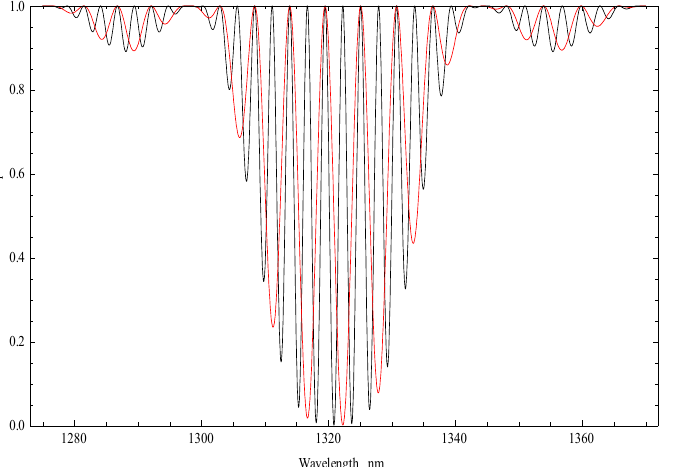
Figure 5. Spectrum for an LPG-based Michelson interferometer ( black ) and Mach–Zehnder interferometer ( red ) for a cavity length of 90 mm and for LPGs operating with the 5th order cladding mode.